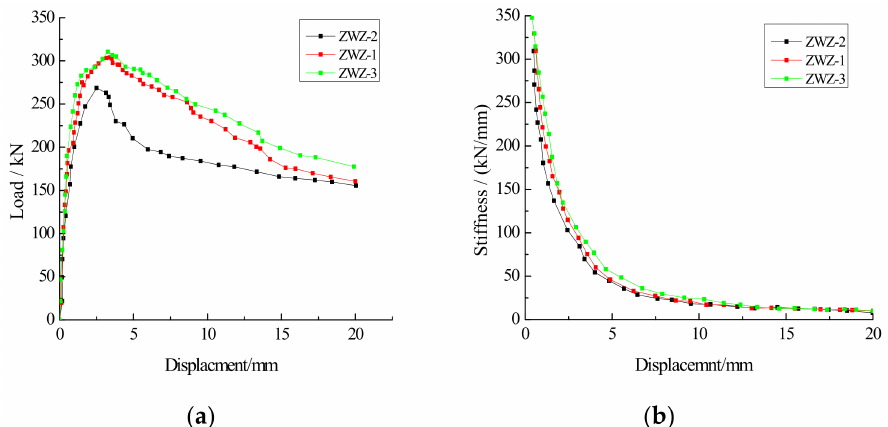
Figure 20. Load–displacement and stiffness–displacement curves of the walls with different mortar strength: ( a ) load–displacement curves; ( b ) stiffness–displacement curves.